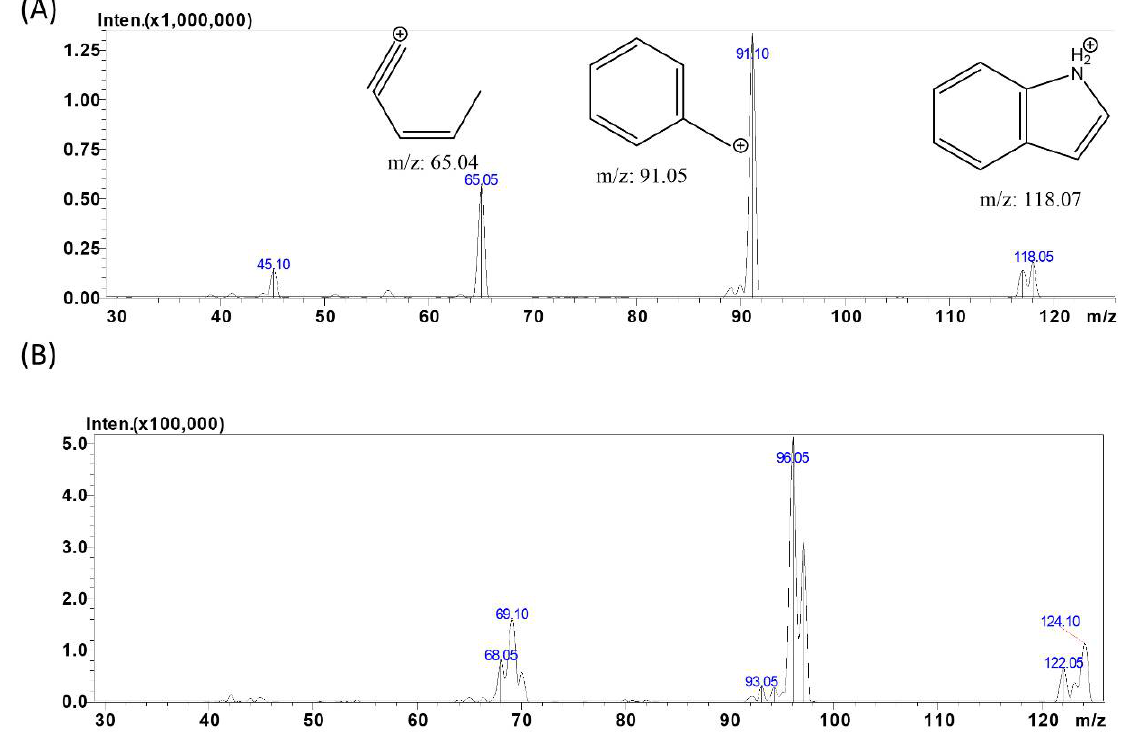
Figure 1. MS/MS product ion spectra of indole ( A ) in positive APCI mode [M + H], shows prominent fragments peak at m / z 91.1, 65.05, and 45.10 at CE-30 units and IS ( B ) shows prominent fragments peak at m / z 96.05 at CE-30 units.